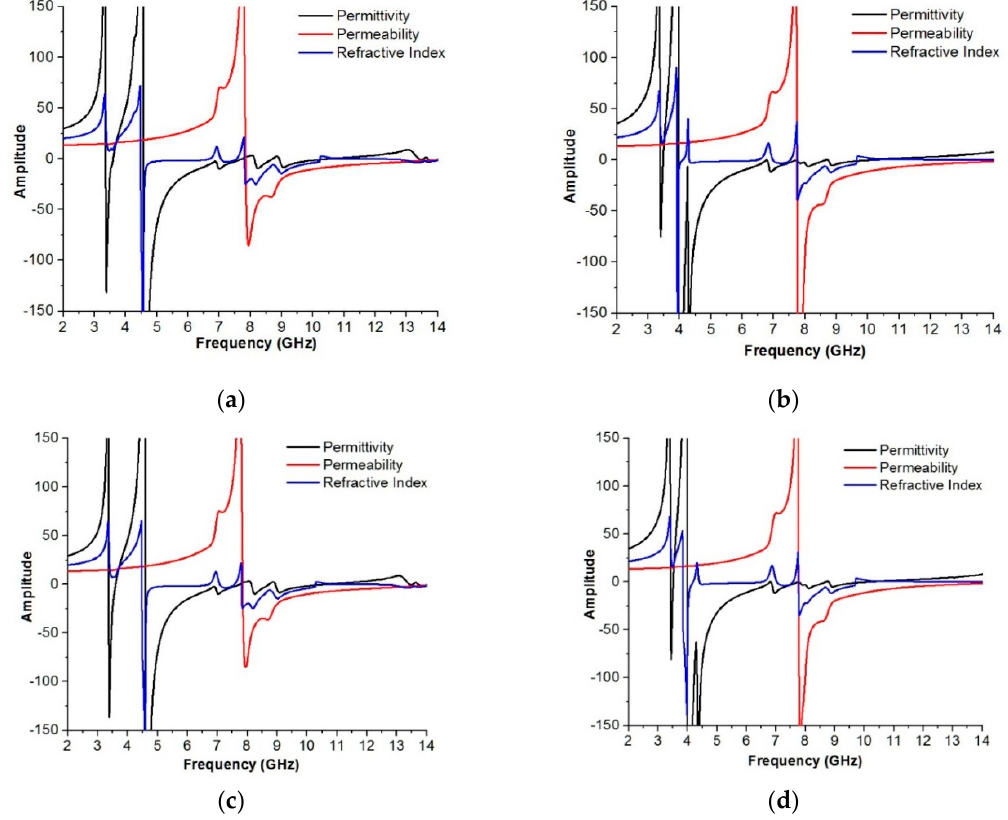
Figure 11. Amplitude of the permittivity, permeability and refractive index at: ( a ) 0°, ( b ) 90°, ( c ) 180°, ( d ) 270° rotations of the 2 × 2 array structure. Table 4. Real values of ε , µ and n at 9.20